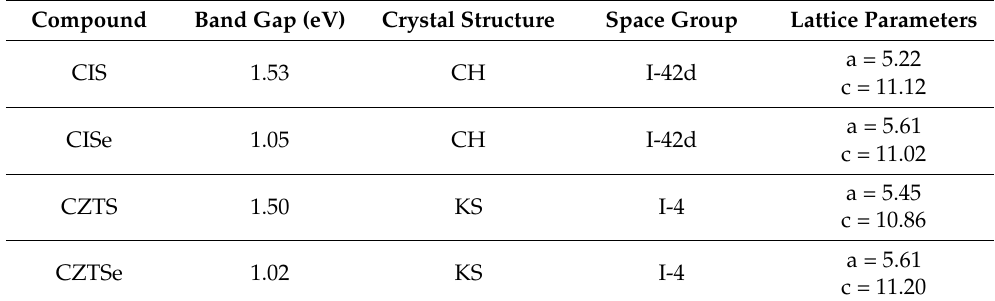
Table 1. Properties of selected ternary and quaternary metal chalcogenide materials (at 300 K). Reproduced with permission from [24]. Copyright American Chemical Society,